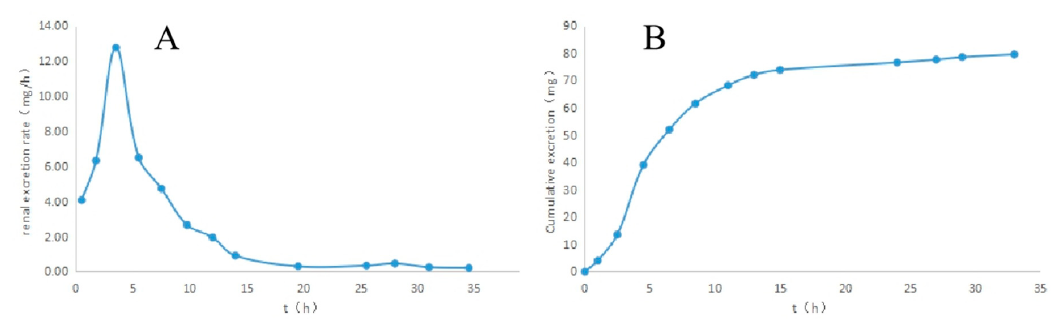
Figure 4. The urinary excretion rate-time curve of naproxen ( A ) and urinary cumulative excretion-time curve of naproxen ( B ).